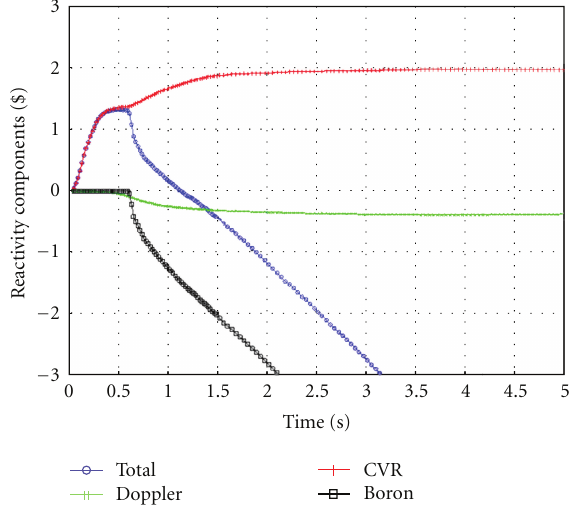
Figure 19: Transient: component reactivity versus time.